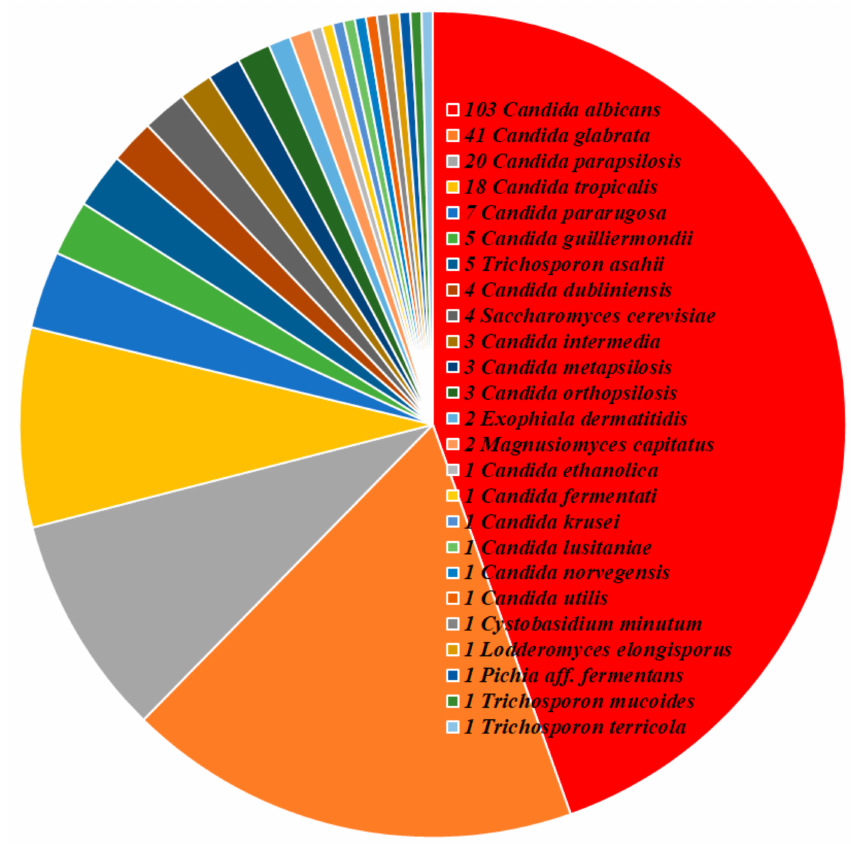
Figure 1. Distribution of species of 231 isolates. The number in front of the name of a species refers to the number of isolates recovered in the present